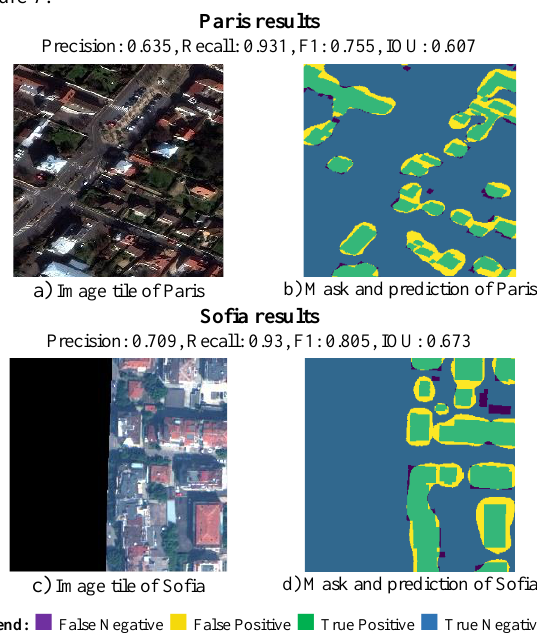
Figure 7. Comparison of performance on a single